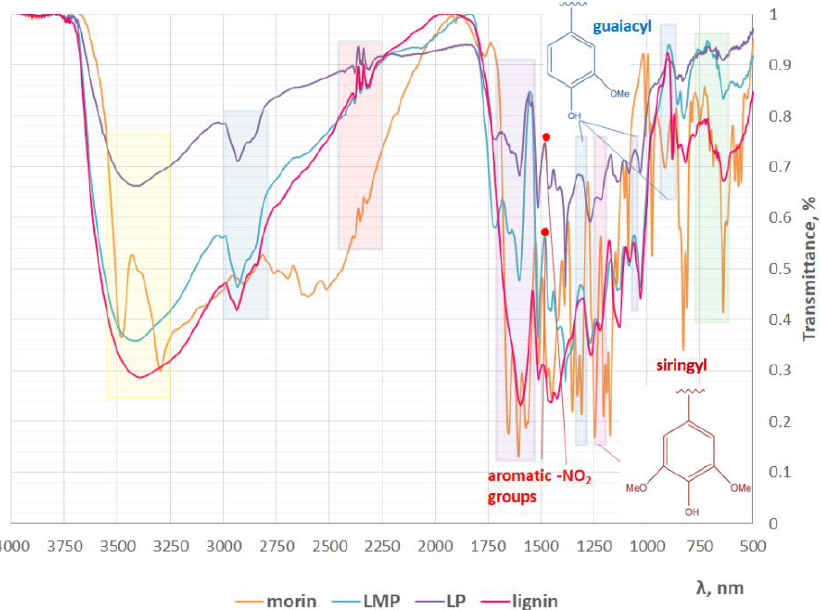
Figure 5. FTIR spectra of morin, alkali lignin, LPs and LMPs. Table 1. FTIR spectra assignments of morin, alkali lignin, LPs and LMPs [22,23].